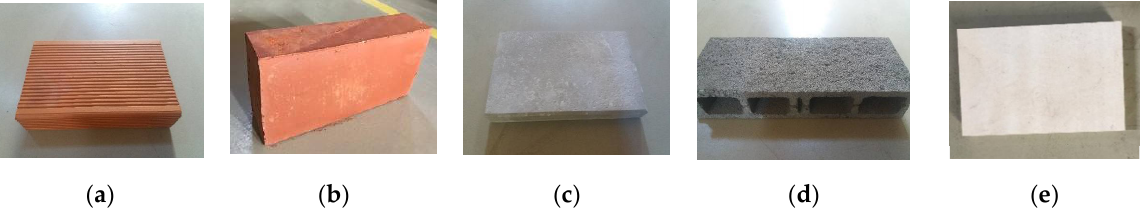
Figure 1. Substrates: hollow ceramic brick ( a ); solid ceramic brick ( b ); concrete slab ( c ); lightweight concrete block ( d ); natural stone slab ( e ).